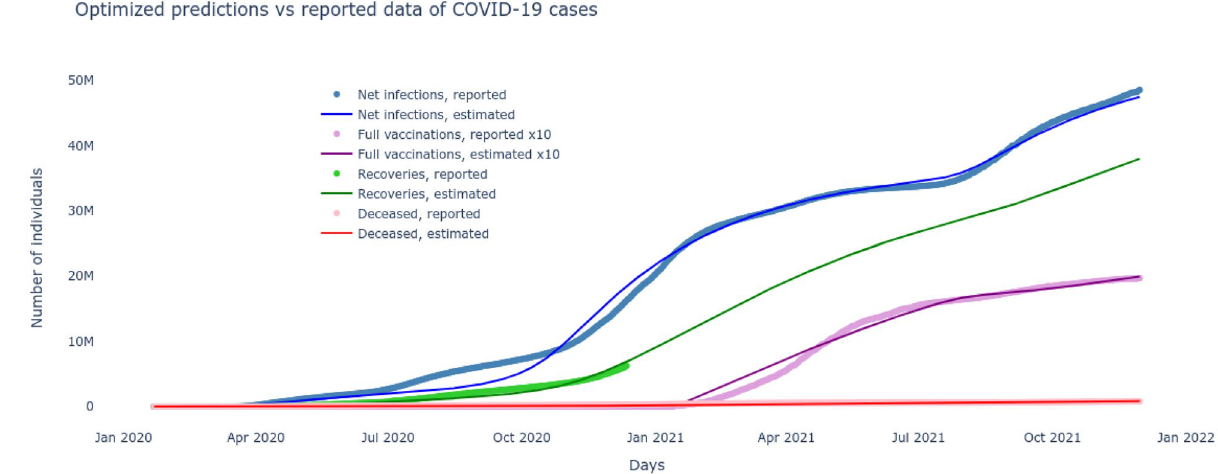
¯ β , v , β v , α f , τ , ρ , δ closely matches